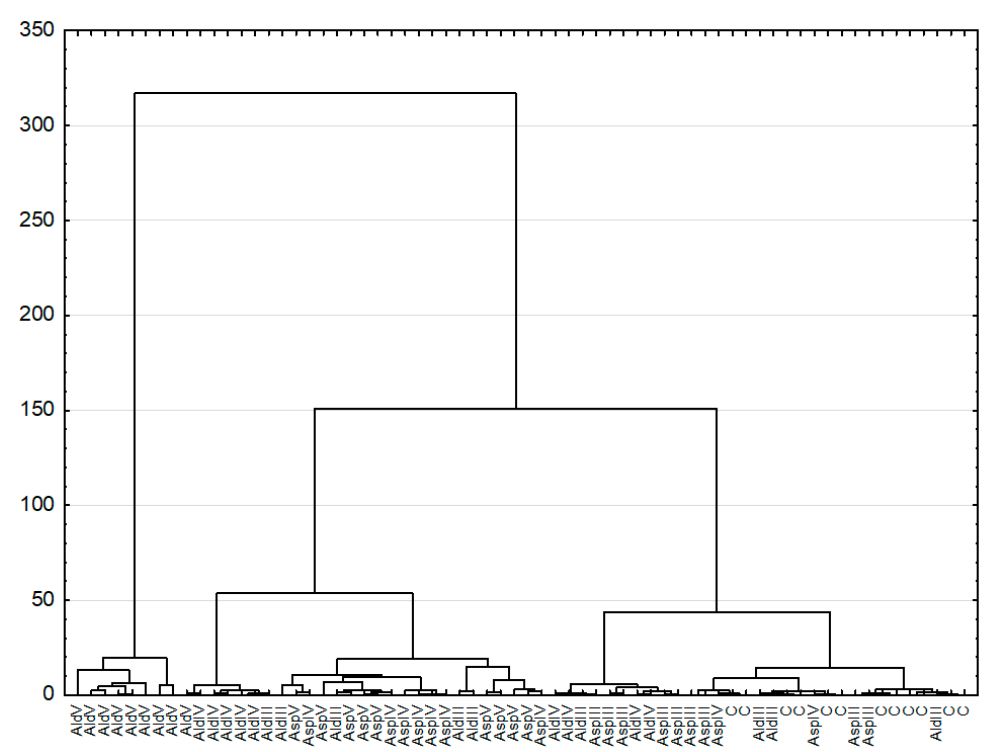
Figure 2. Dendrogram with group identified in the cluster analysis (Ald—alder, Asp—aspen, III-V—different decay class, C—control). Bulk density, porosity, moisture, capillary water capacity, aggregate distribution, and WDPT were used for dendrogram.